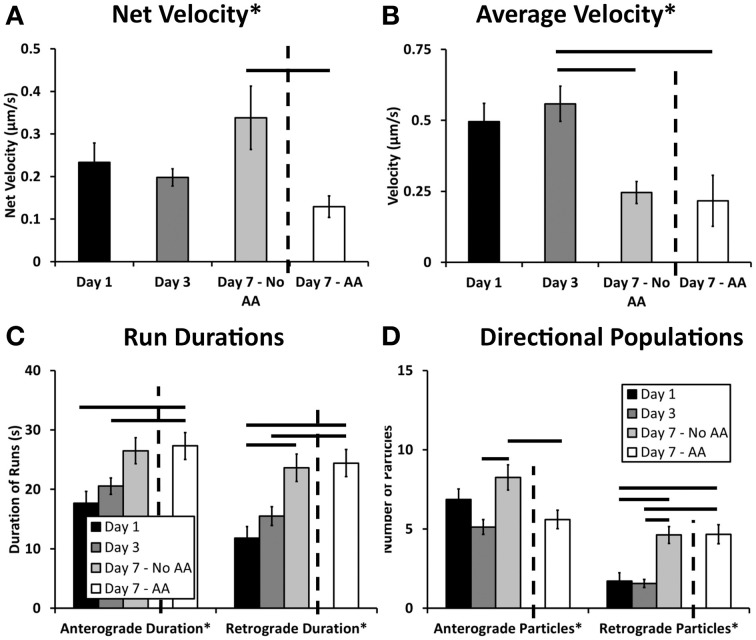
Kymograph analysis provided a clear picture of the dynamics of ribosomal transport. (A) Net velocity, a measurement that provides a relative comparison of the bulk transport occurring in the cell, showed increased levels after 7 days. These levels were decreased when the cultures were treated with ascorbic acid indicating an effect of this treatment and early myelination on ribosomal transport; (B) In both day 7 treatment groups, the average velocity was decreased compared to day 3; (C) Anterograde and retrograde durations varied over the course of the experiment showing significant differences between early and late time points; (D) The number of anterograde particles increased after 7 days in the absence of ascorbic acid compared to both the day 3 and day 7 ascorbic acid treated groups. Additionally, there was an increase in retrograde particles in both the day 7 groups compared to the earlier time points, likely influencing the observed changes in net velocity (Means ± SEM) Statistics: 1-way ANOVA (*
p < 0.05); Tukey HSD (−
p < 0.05).